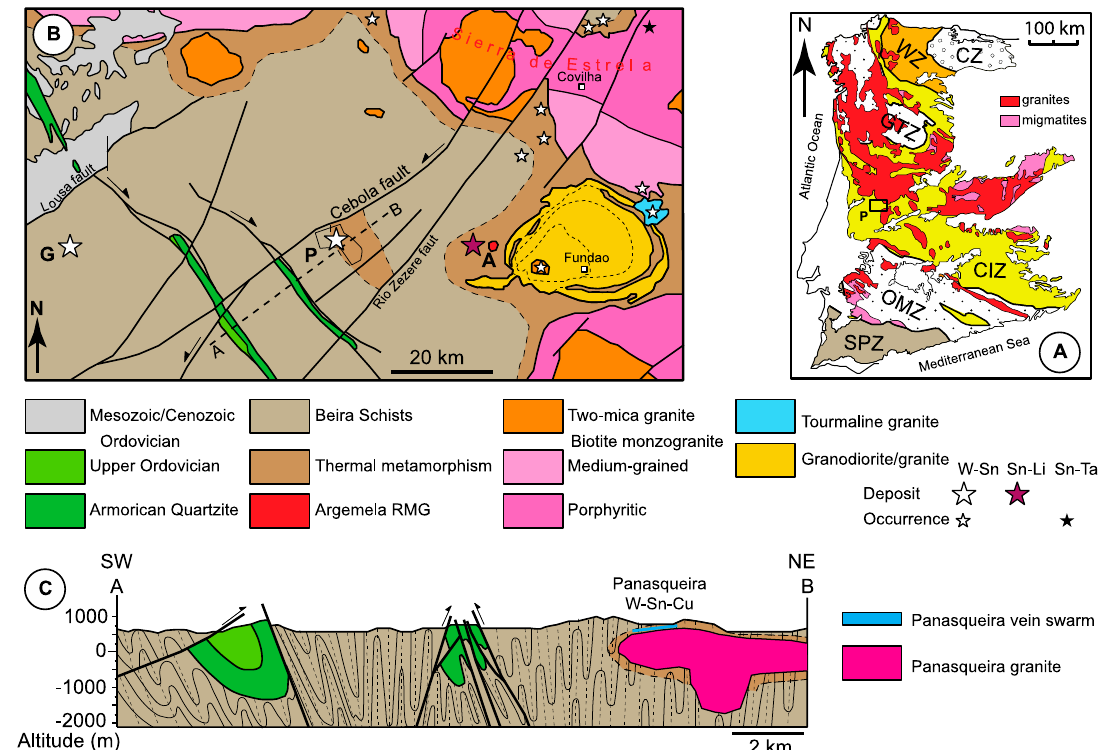
Figure 1. Geological setting of the Panasqueira deposit. ( A ) The regional setting, with the main lithotectonic units (simplified from [20]): SPZ (South Portuguese Zone), GTZ (Galicia-Tras-os-Montes Zone), OMZ (Ossa Morena Zone), CZ (Cantabrian Zone) allochthonous units; CIZ (Central Iberian Zone), WZ (Western Asturian-Leon Zone) autochthonous units. P: location of Figure B. ( B ) Geologic map of the Panasqueira area (located in Figure A) adapted from [12–15]. A: Argemela; G: Gois; P: